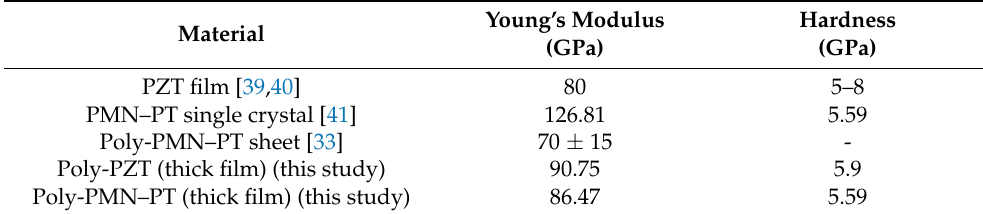
Table 3. Comparison of the Young’s modulus and hardness of the PZT and PMN–PT materials.